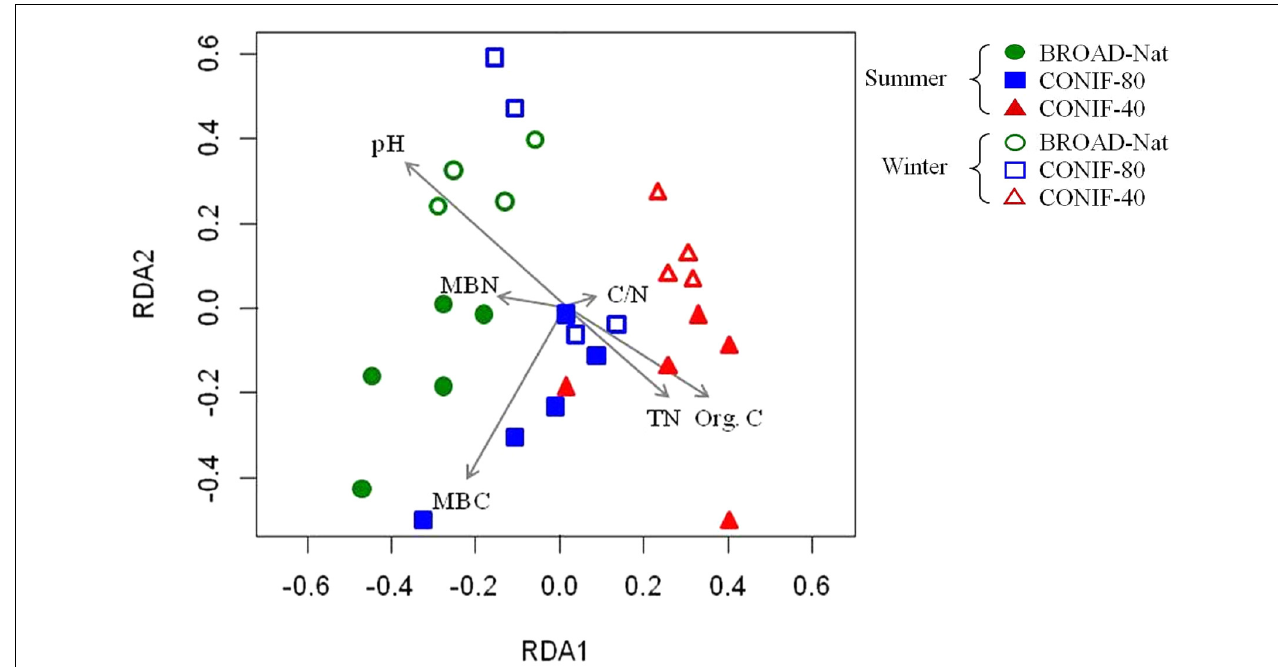
FIGURE 3 | Redundancy analysis of bacterial community based on the distribution of OTUs among three forest soils in different seasons. Org. C, organic carbon; TN, total nitrogen; C/N, organic C/TN ratio; MBC, microbial biomass carbon; MBN, microbial biomass nitrogen.